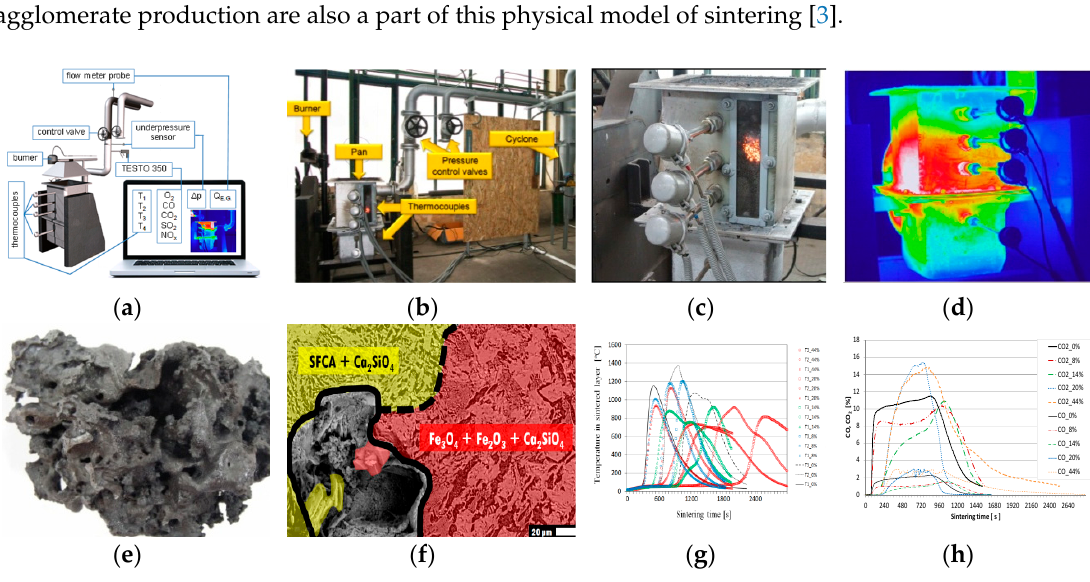
Figure 1. Laboratory sintering pan and modelling of agglomerate production at UMET FMMR TUKE (Košice, Slovakia)—reproduced from [3], with permission from the Technical University of Košice, Slovakia, 2015. ( a ) Illustration of the laboratory sintering pan; ( b ) real laboratory sintering pan; ( c ) sintering in the laboratory sintering pan; ( d ) infrared temperature measurement in the iron sintering process; ( e ) final agglomerate; ( f ) structure of agglomerate; ( g ) temperatures in the sintered layer; and ( h ) emission profile of the sintering process.